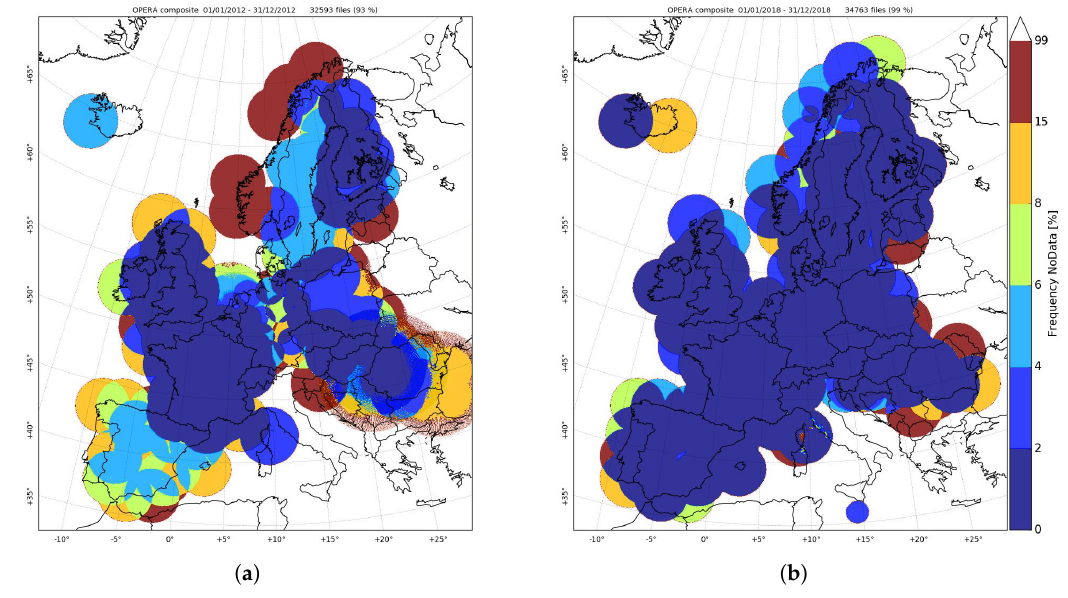
Figure 2. Frequency of nodata values in ( a ) 2012 and ( b )